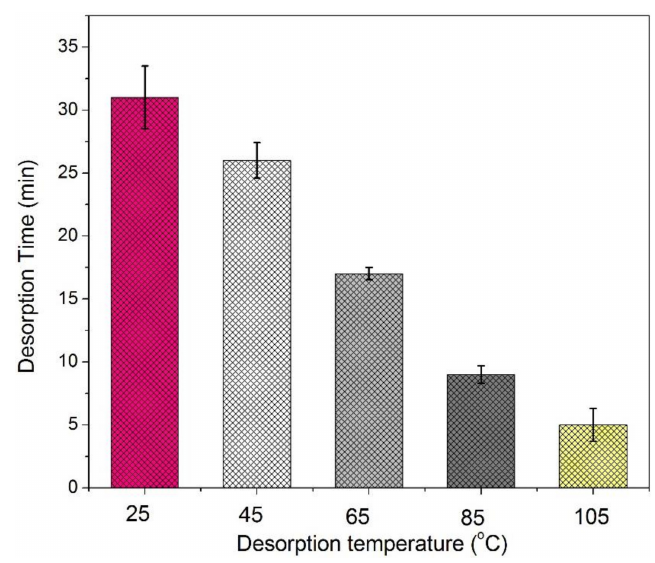
Figure 12. Desorption time of 60% M-P at different temperatures ( n = 3).